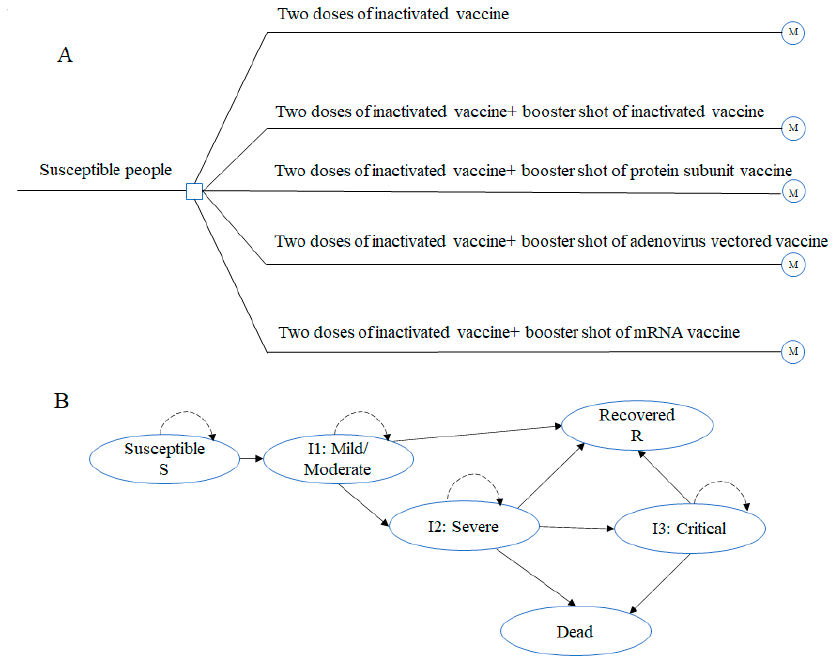
Figure 1. Decision-analytical Markov model using a susceptible–infectious–recovered (SIR) structure. ( A ) Decision-analytical Markov model; ( B ) Susceptible-Infected-Recovered (SIR) structure.